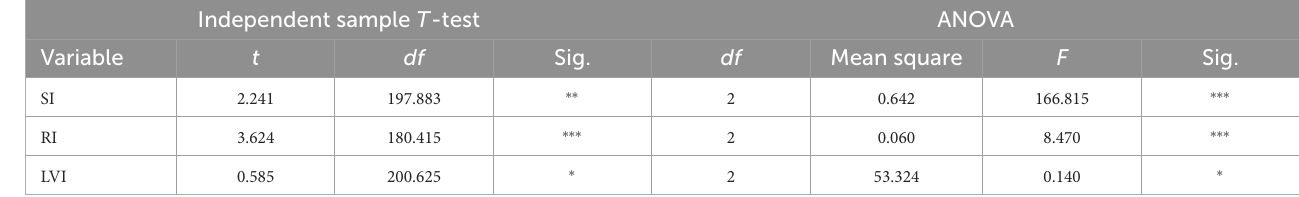
TABLE 3 Significance test of the difference between groups after cluster analysis.